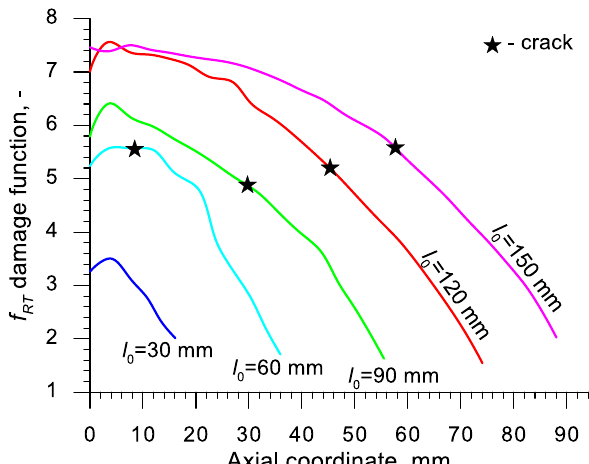
Figure 19. Distributions of the damage function in the axis of a rotationally compressed sample, determined on the basis of the Cockcroft and Latham criterion.